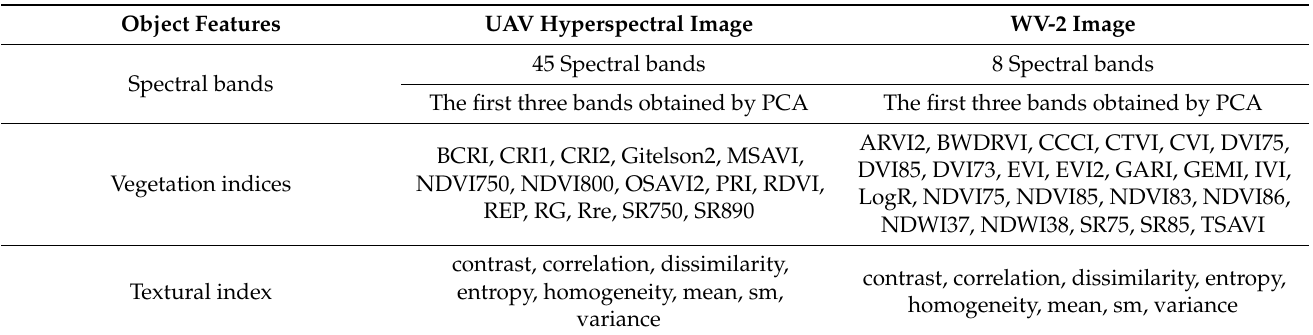
Table 3. Object features extracted for classification